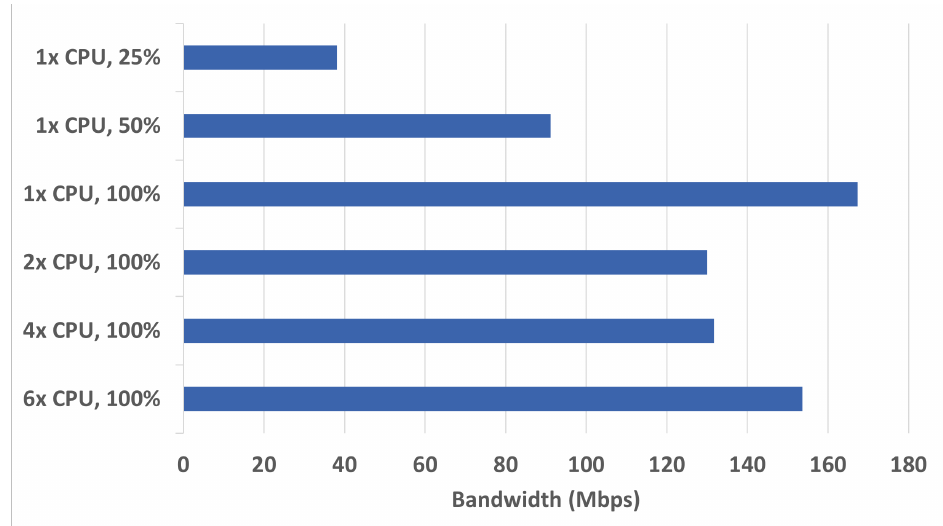
Figure 6. Performance of the simulation model with various VM